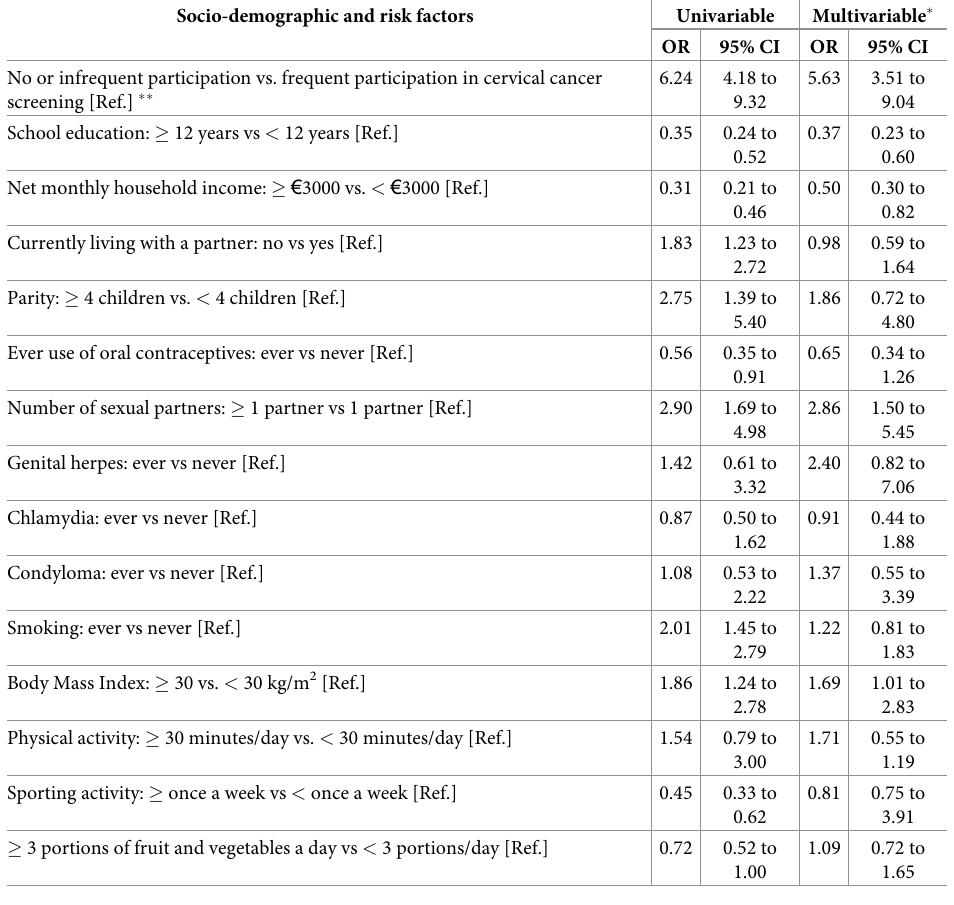
Table 4. Factors associated with cervical cancer: Univariable and multivariable conditional logistic regression (217 cases and 652 controls). Socio-demographic and risk factors Univariable Multivariable � OR 95% CI OR 95%